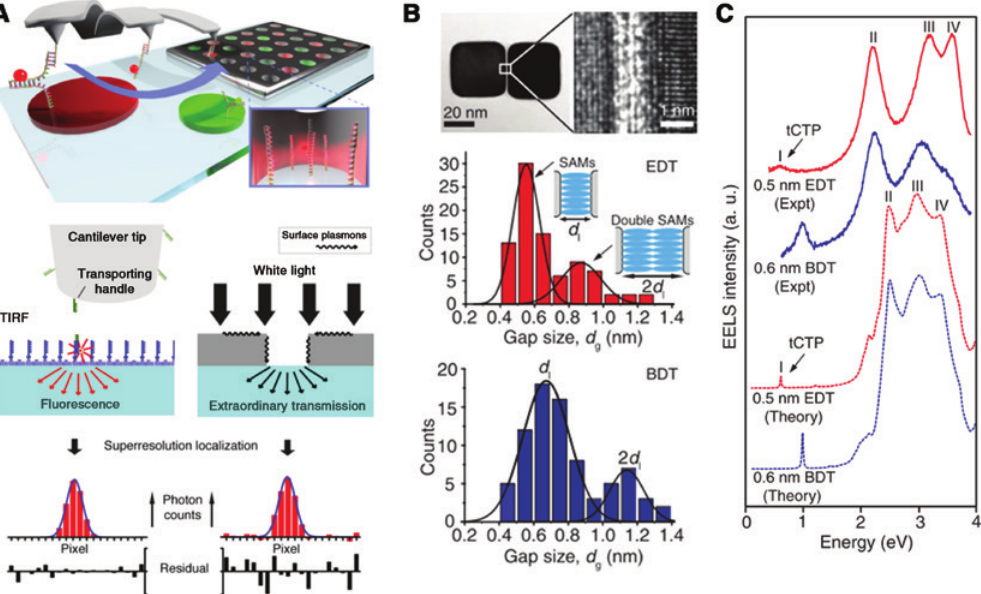
Figure 5: Surface functionalisation of plasmonic particles and hot spots. (A) Functionalisation of plasmonic hot spots with single DNA molecules by an AFM cantilever. The position of the AFM’s transporting handle is localised by fitting Gaussians to the fluorescence of a pasted anchor in total internal reflection fluorescence microscopy mode. Similarly, white light extraordinarily transmitted through the nanoaperture by surface plasmons is used to localise the apertures by Gaussian fitting of the intensity distribution. Adapted from [58]. (B) Direct observation of quantum tunneling between two Ag nanocubes bridged by tuning the surface molecules, with a high-resolution TEM image of the junctions and histograms of the gap sizes. Adapted from [59]. (C) Elec- tron energy loss spectra with occurrences of quantum tunneling that are directly observable by tunneling charge transfer plasmon peaks. Quantum-corrected simulations of the extinction spectra confirm these peaks. Adapted from